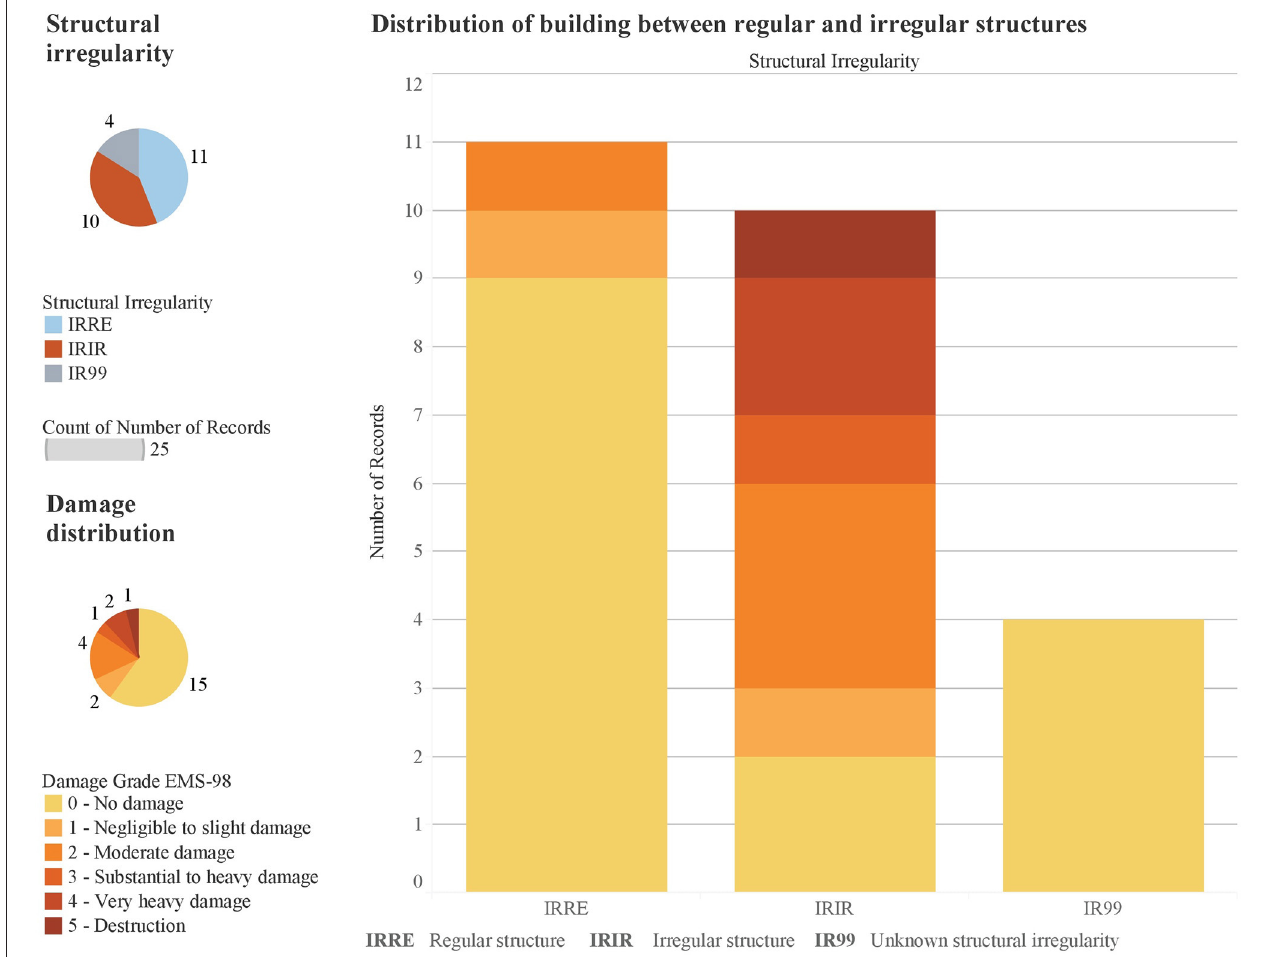
FIGURE 9 | Dashboard showing the distribution of regular and irregular structures and the impact on the damage grade of the building.